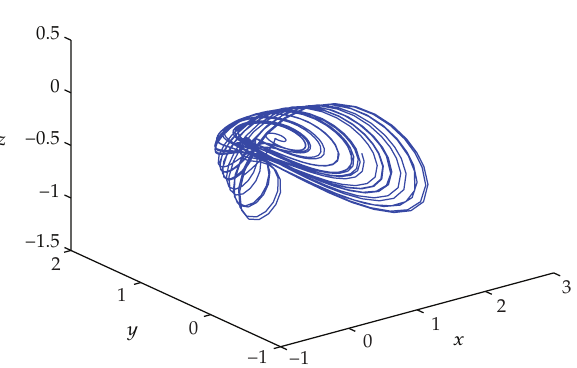
Figure 2: Chaotic attractor of system (cid:5) 2.2 (cid:6) .